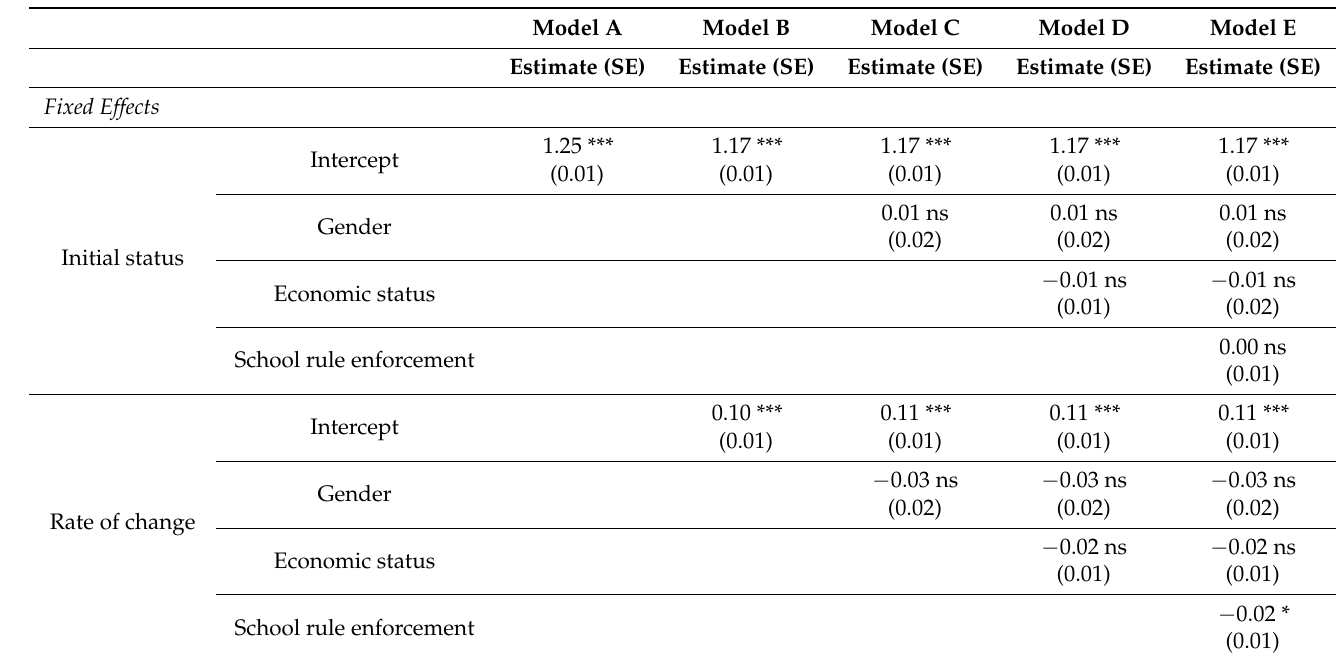
Table 5. Results of fitting a multilevel model for change to the cyber victimization data: fixed effects, variance components, and goodness of